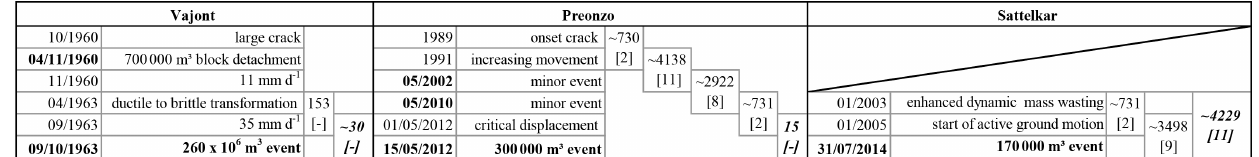
Table 7. Relevant dates for historic failures of Vajont (ITA), Preonzo (CH) and the Sattelkar (AUT). Time period in italics–bold used for Fig. 8. Time intervals in days ( ∼ for rough estimations) and years in square brackets; sum of days based on the first day of the month if only month as reference is available from the literature (Petley and Petley, 2006; Anker et al., 2016; Sättele et al., 2016; Loew et al., 2017). When only the month is given, dates are in the format month/year; when the day is also given, dates are in the format day.month.year. Further explanation is in the